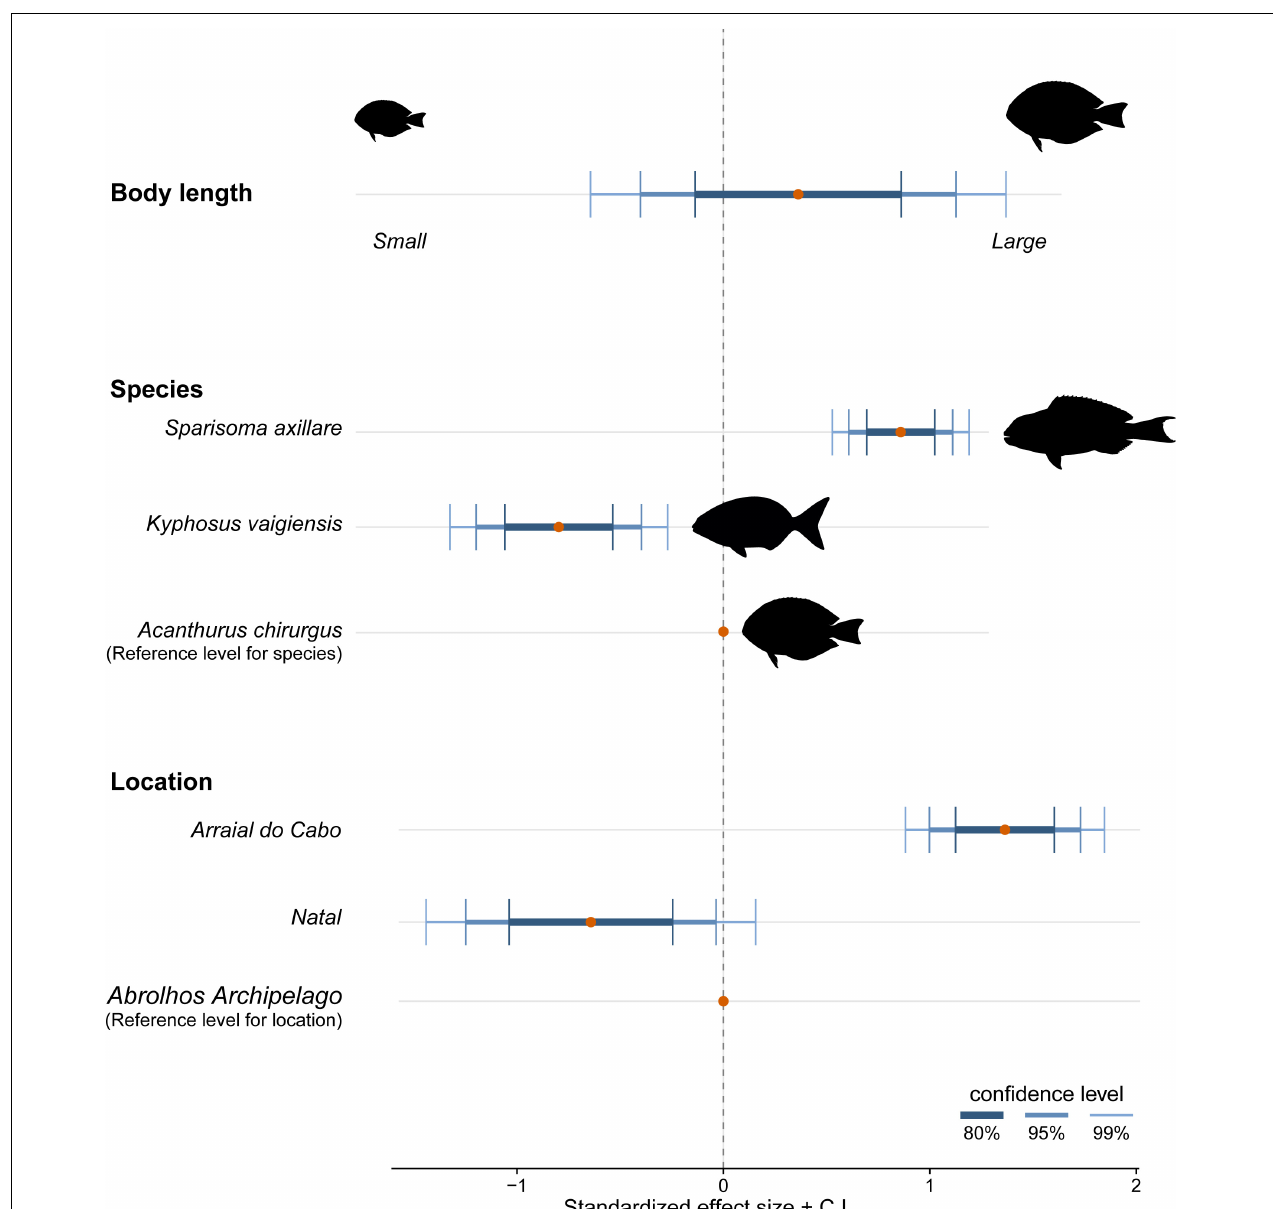
FIGURE 5 | Effect sizes and confidence interval at three levels (80, 95, and 99%) of significance resulted from the zero-inflated Poisson generalized linear model testing the effect of body length, species ID, and location on the number of debris